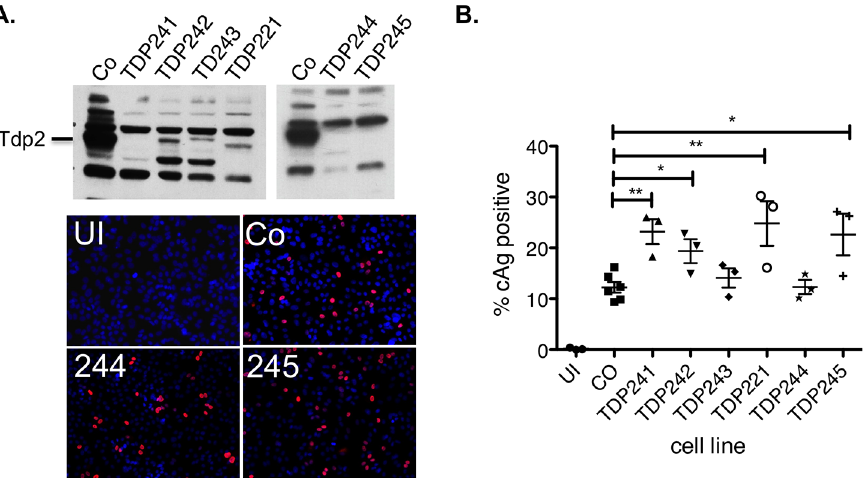
Fig 2. HBV infection in HepG2-NTCP Tdp2 knockout cells. HepG2-NTCP-Cas9 cells (control or Co) and six independent Tdp2-deficient clones (Tdp241, -242, -243, -221, -244 and -245) were infected with